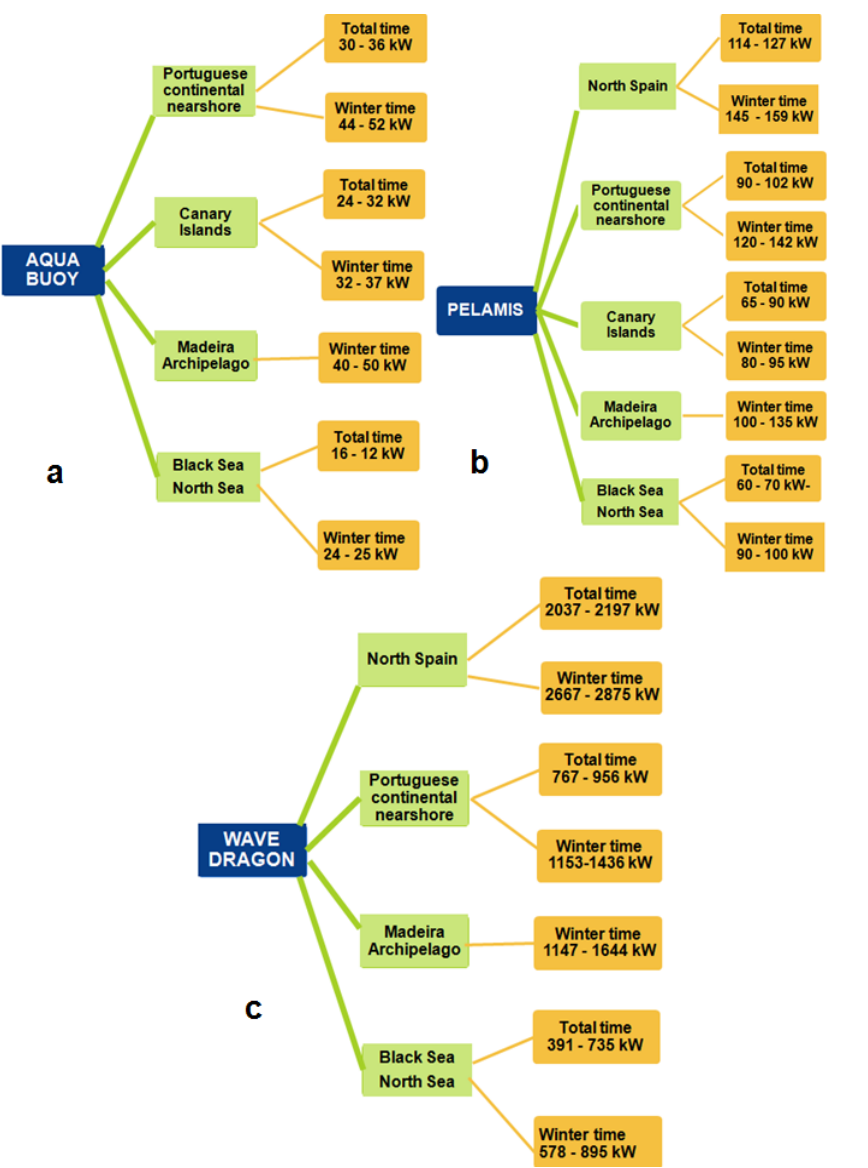
Figure 5. Expected electric power in various coastal environments. ( a ) Aqua Buoy; ( b ) Pelamis; ( c ) Wave